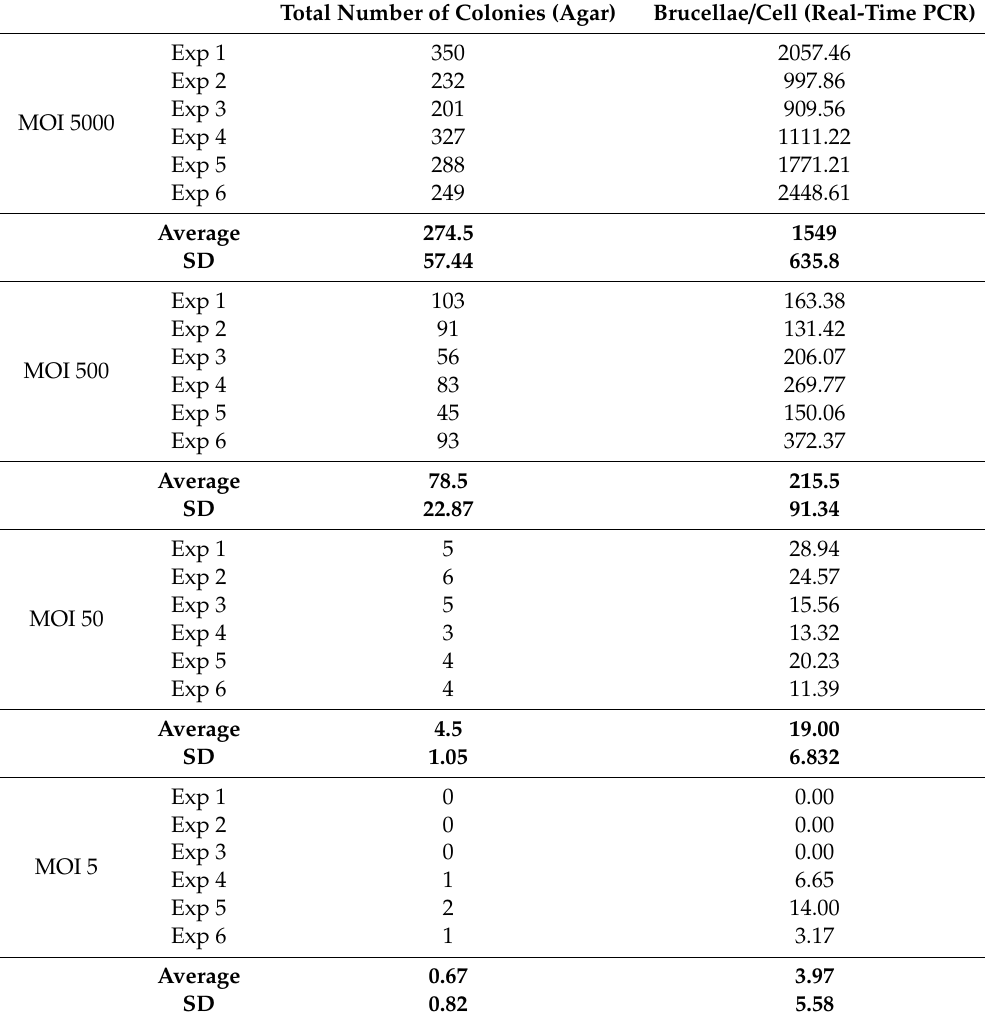
Table 1. Detailed results from all the experiments conducted to determine the number of incorporated brucellae in ovine macrophages infected with Brucella at various MOIs, 2 days post-infection either from 500 infected and lysed macrophages seeded in blood agar dishes or from 50,000 infected macrophages analyzed by Real-Time PCR. Each MOI condition was repeated 6 times (six di ff erent experiments on macrophages of 6 di ff erent sheep). MOI: multiplicity of